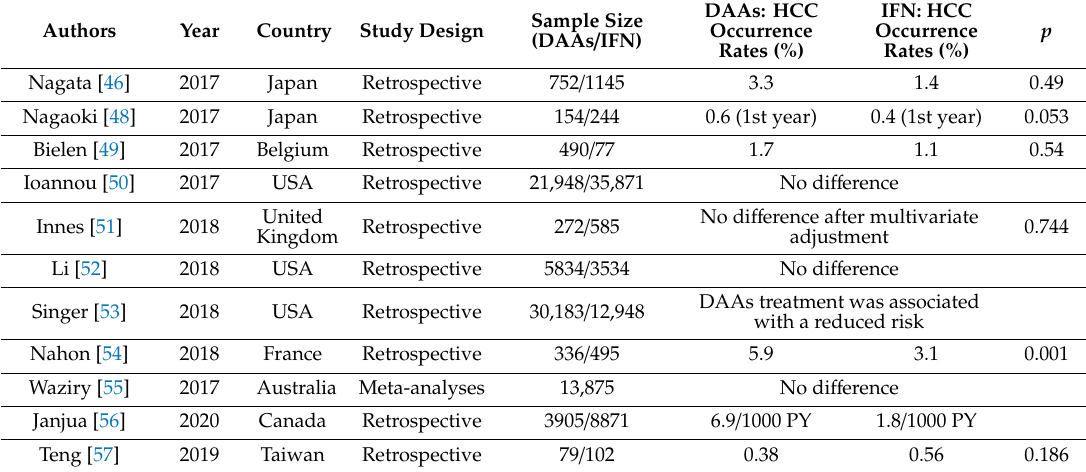
Table 3. HCC occurrence compared to DAAs and IFN-based